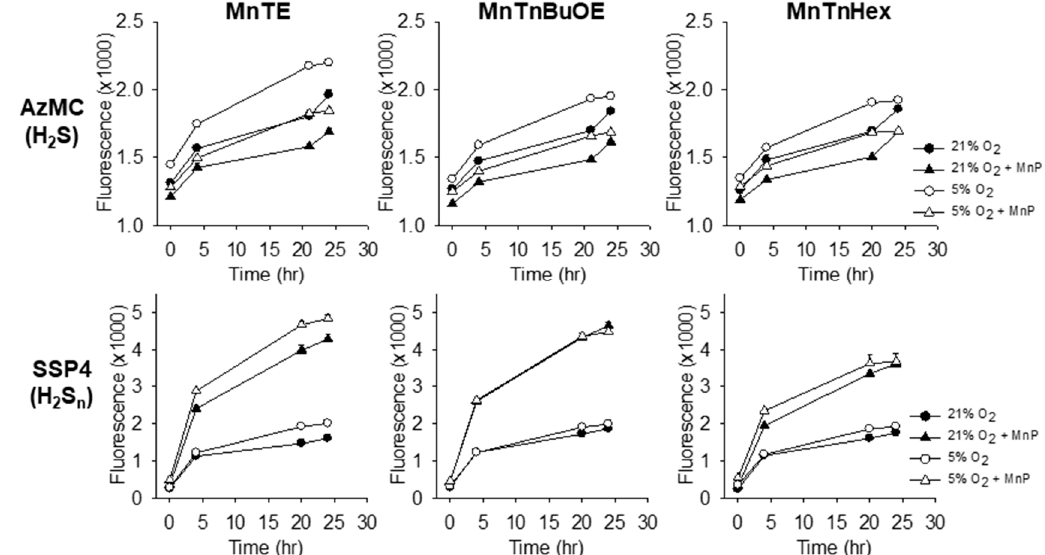
Figure 4. Effects of 1 μ M MnPs on cellular H 2 S (AzMC) and polysulfide (H 2 S n ; SSP4) in bone marrow- derived stem cells in hyperoxia (21% O 2 , solid symbols) and physioxia (5% O 2 , open symbols). Intracellular H 2 S was increased ( p < 0.01 ) in physioxic cells at all but 24 h, whereas polysulfides were unaffected. All MnPs decreased intracellular H 2 S and increased intracellular polysulfides in both normoxia and hypoxia ( p < 0.001) . Mean +SE, n = 8 wells per treatment, error bars may be covered by symbols.